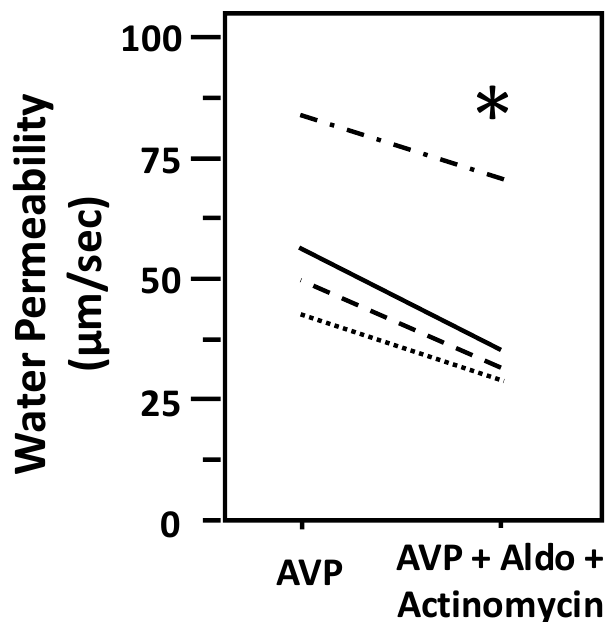
Figure 3. Aldosterone-attenuated osmotic water permeability in male rat terminal IMCDs was not reversed by inhibition of gene transcription with actinomycin. Terminal IMCDs were perfused with 50 pM vasopressin (AVP), then treated with 1 µM actinomycin for 30 min before adding 500 nM aldosterone (Aldo) for 30 min. Each line represents a separate IMCD from a different rat. * P < 0.05 AVP control vs. AVP with Aldo plus actinomycin, N = 4 rats/condition.